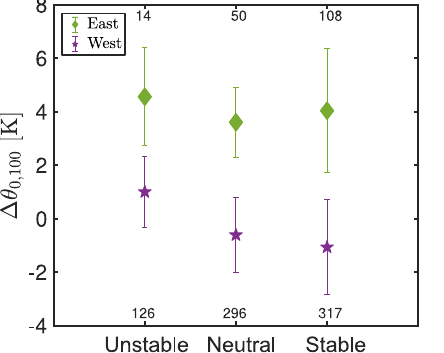
Figure 4. Availability of LOS measurements as a function of the range with a CNR threshold of − 26.5dB (green) and a dynamic filter (blue).